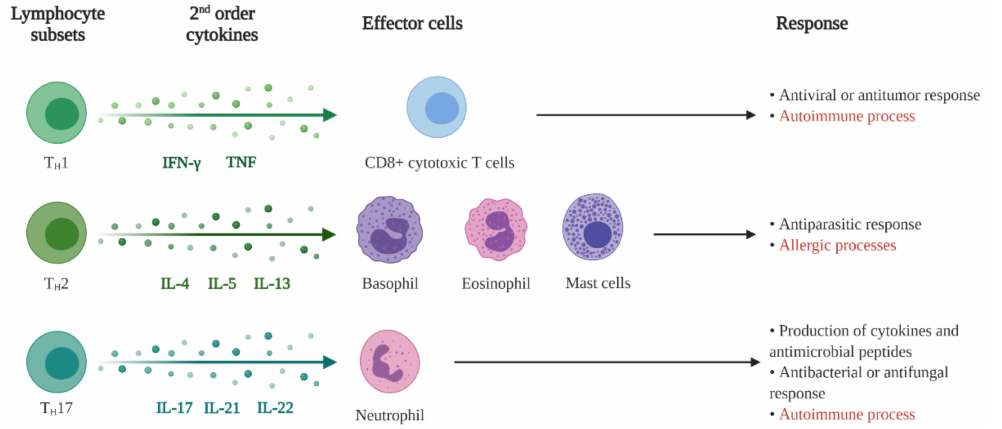
Figure 4. Lymphocytes activation through different